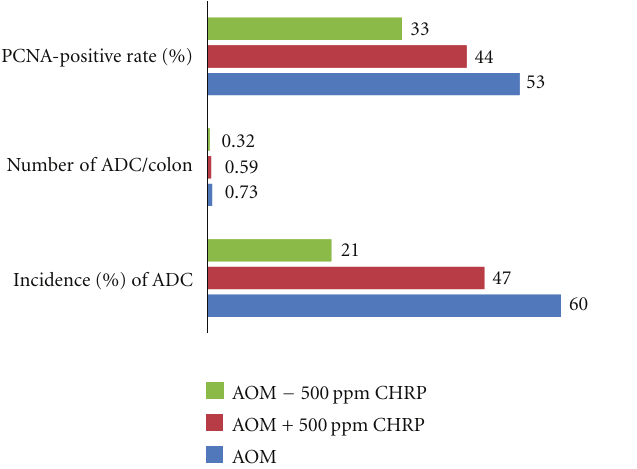
Figure 4: CHRP in diet suppresses 4-NQO-induced rat tongue squamous cell carcinoma